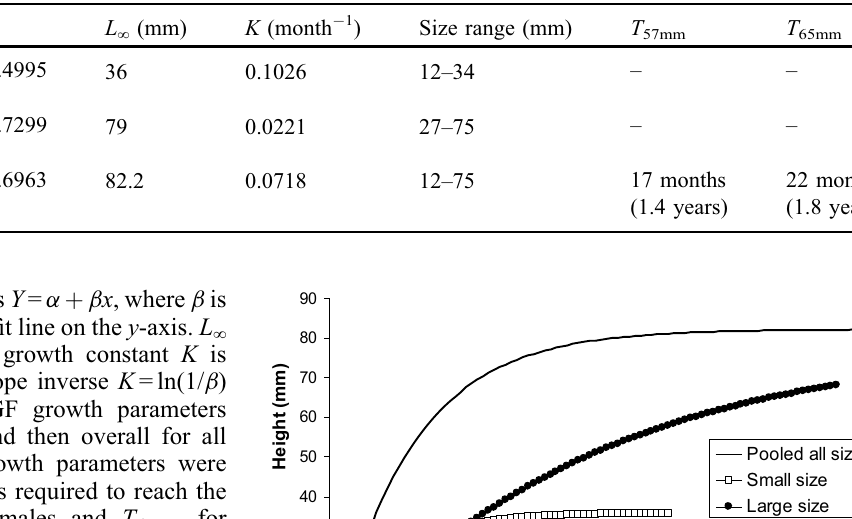
Table 1. Value of von Bertalanffy growth parameters of two size groups of the freshwater E. elliptica oyster reared in cages in the Pendjari River (Benin) from January to December 2009.